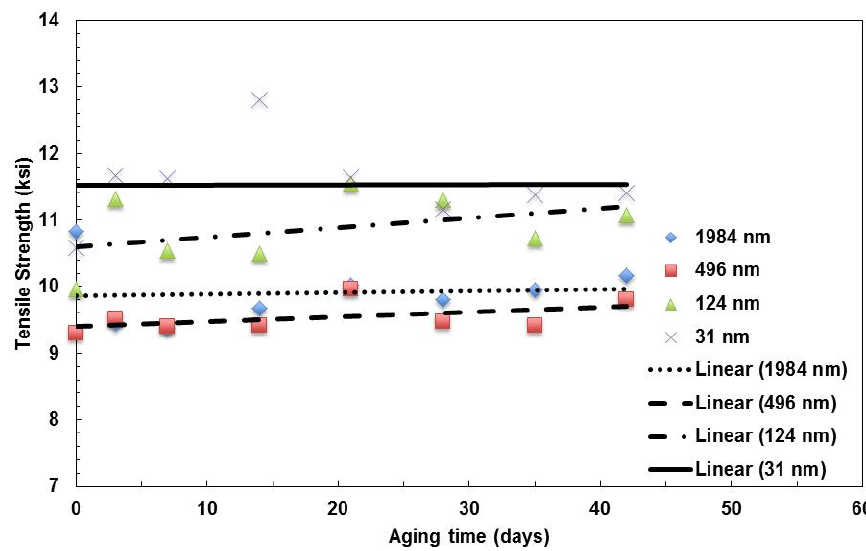
Figure 3. Summary of the change in tensile strength with aging time for films with various layer thicknesses aged at 100 °C.